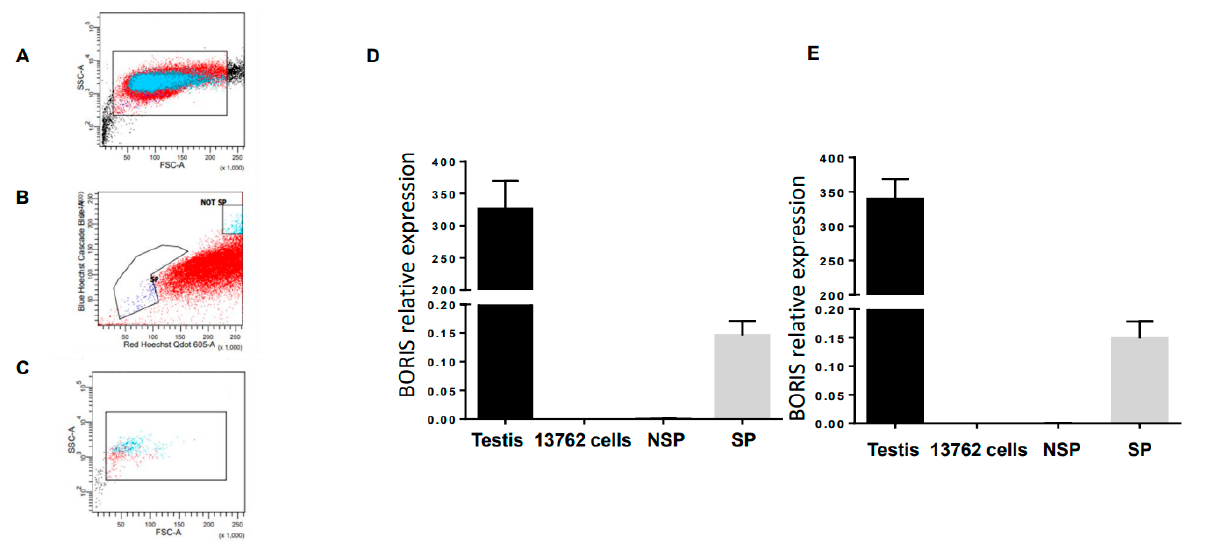
Figure 1. Boris expressed in the side population of rat mammary tumor cell line, the 13762 MAT B II, presenting CSC. ( A – C ) Flow cytometry and sorting gates for side population (SP) and non-side population (NSP). ( D and E ) Total RNA from the 13762 MAT B II cells, SP ( D ), and NSP ( E ) isolated from the 13762 MAT B II cells, testis, and liver were extracted, and BORIS expression was analyzed by qRT-PCR. The results were normalized to GAPDH expression and related to BORIS expression in liver cells. Error bars represent the mean ± SD (n = 3). Two sets of BORIS primers have been used, set 1 ( B ) and set 2 ( C ).